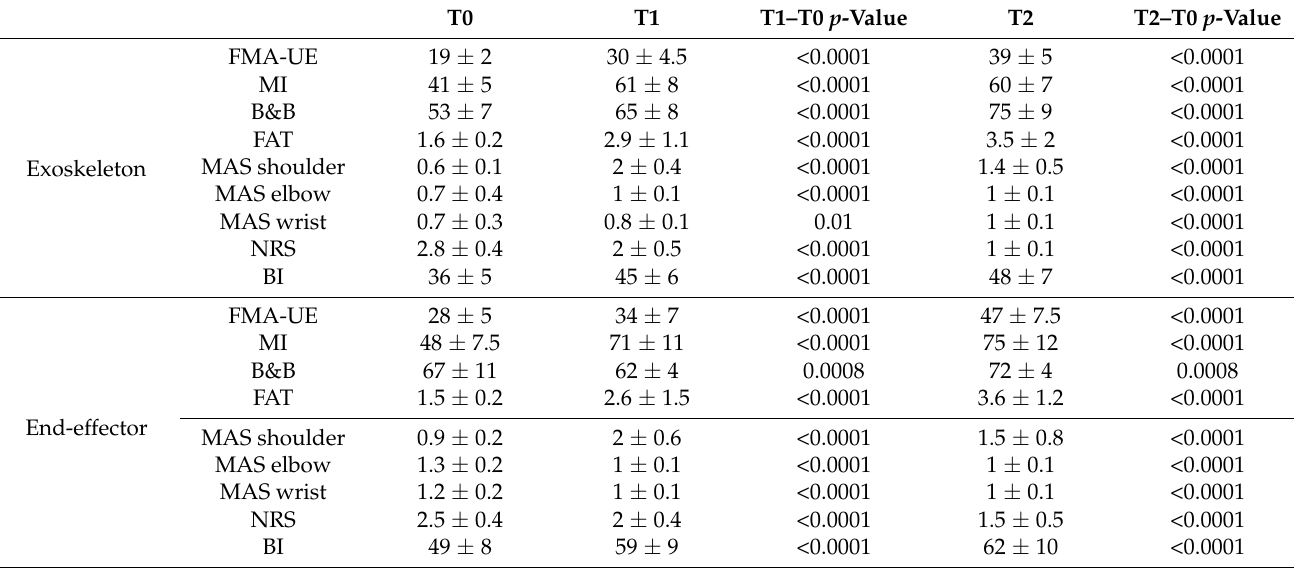
Table 3. Means and standard deviation of the outcome